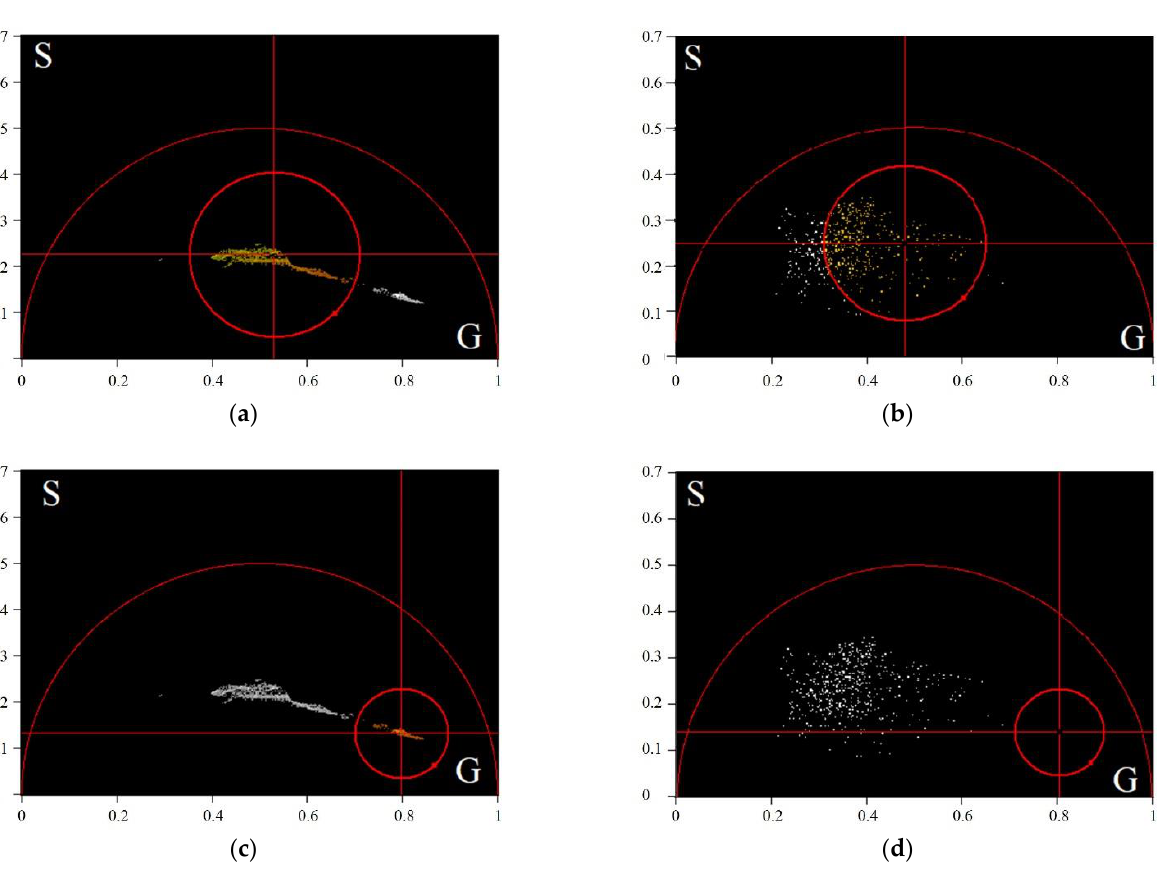
Figure 6. The class areas on phasor plots of the average TPAF lifetime t m images of the exosome samples presented in Figure 5: the first class position on the phasor plot for the CRC patient ( a ) and the CP patient ( b ), the second class position on the phasor plot for the CRC patient ( c ) and the CP patient ( d ). The first class parameters: 𝑔 с,1 = 0.80, 𝑠 𝑐,1 = 0.14, and 𝑅 1 = 0.51; the second class parameters: 𝑔 с,2 = 0.53, 𝑠 𝑐,2 = 0.23, and 𝑅 2 = 0.71. Here, 𝑔 𝑐,𝑗 ,𝑠 𝑐,𝑗 , and 𝑅 𝑗 are coordinates of the center and radius of the 𝑗 − 𝑡ℎ class.